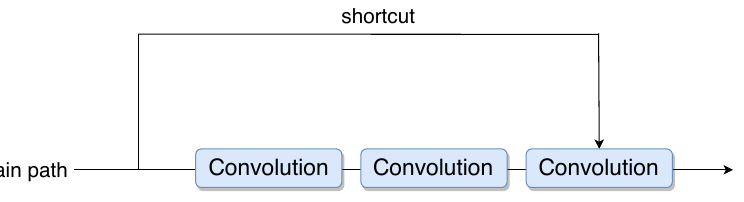
Figure 5. Residual